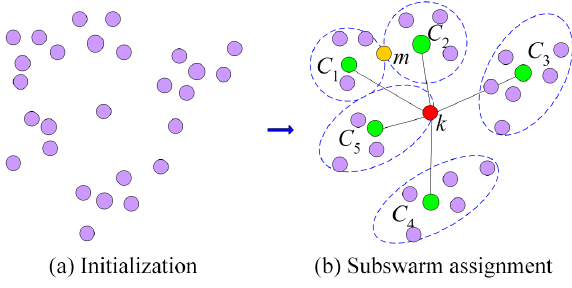
Figure 2. Main process of the subswarm